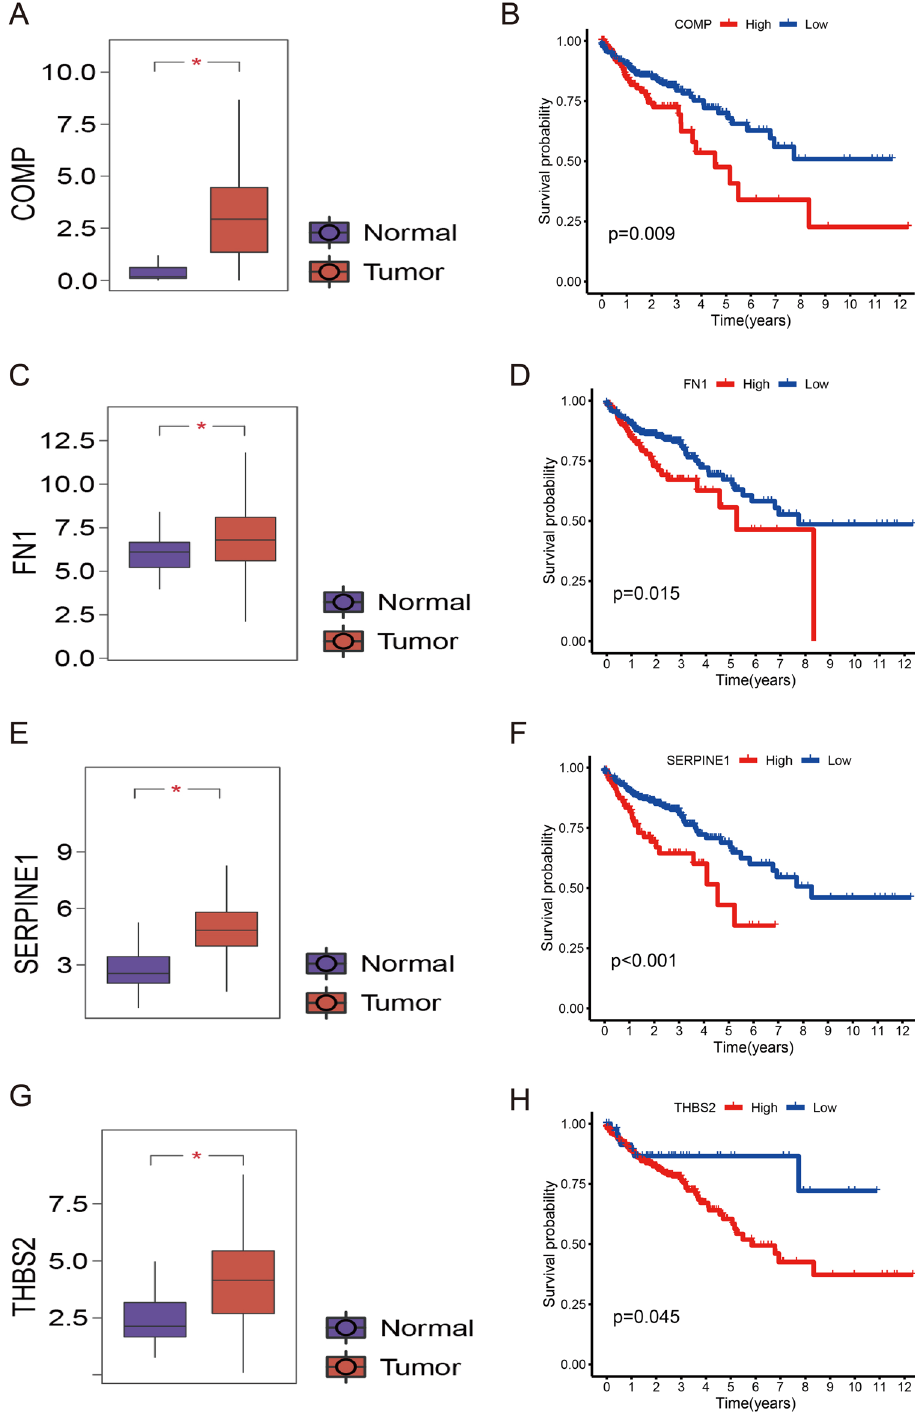
Figure 9. Analysis of target genes. The expression of ( A ) COMP, ( C ) FN1, ( E ) SERPINE1, and ( G ) THBS2 between normal and tumor tissues. The survival analysis of ( B ) COMP, ( D ) FN1, ( F ) SERPINE1, and ( H )